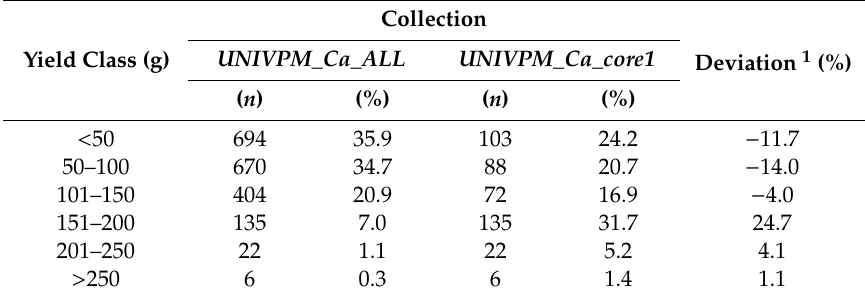
Table 3. Number of accessions and relative frequencies of UNIVPM_Ca_ALL and UNIVPM_Ca_core1 according to the yield classes.